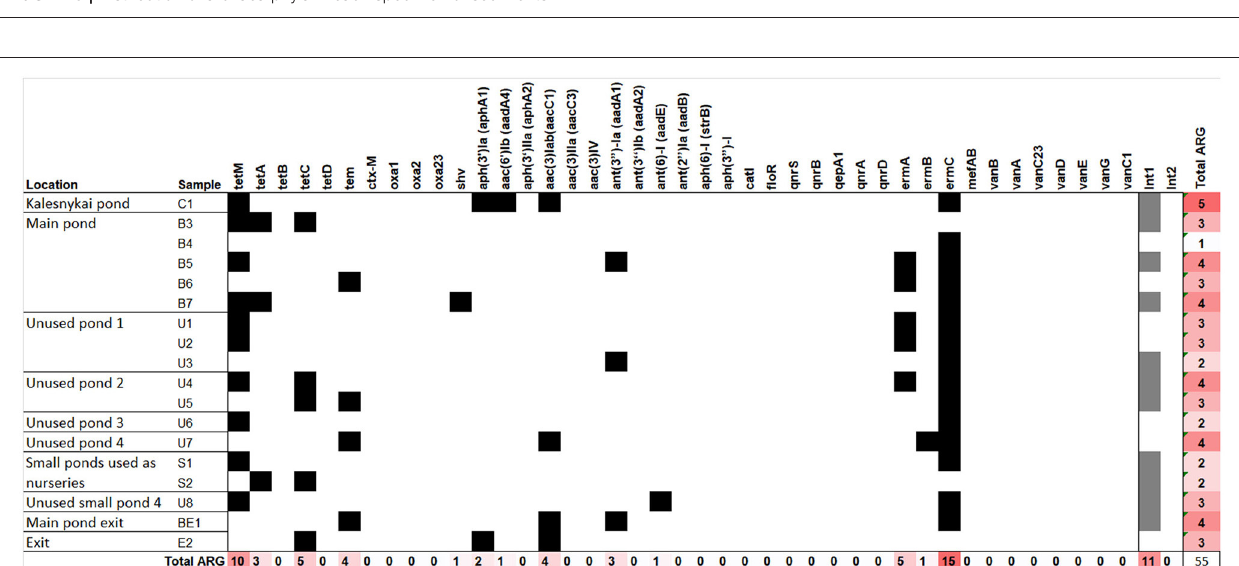
FIGURE 6 | The antibiotic resistance genes detected in the total DNA of fishery pond sediments. Black squares denote the gene was detected. The same samples were tested for the presence of class I and II integrase genes, the presence of the genes is indicated by gray squares.